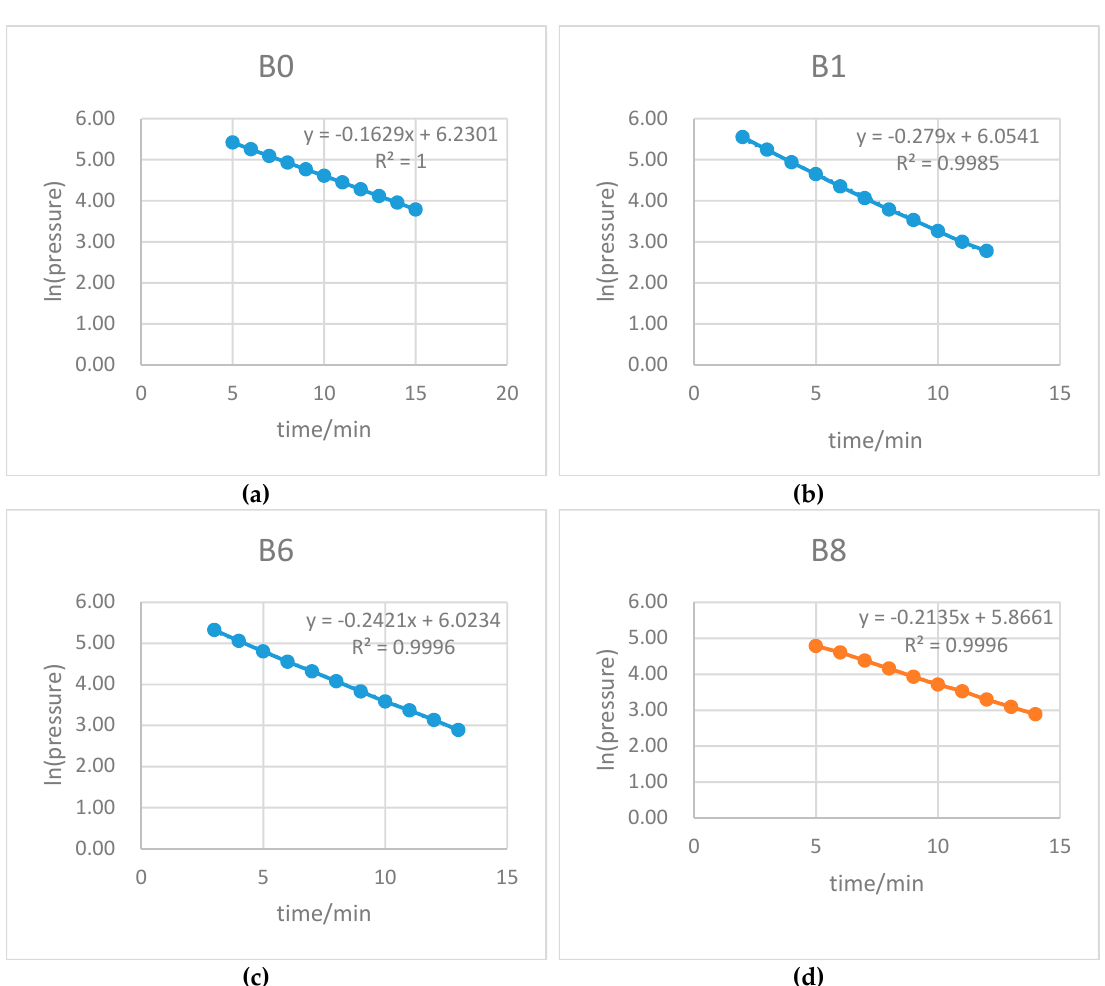
Figure 14. Intrinsic air permeability with W/B 0.35 and W/B 0.30.